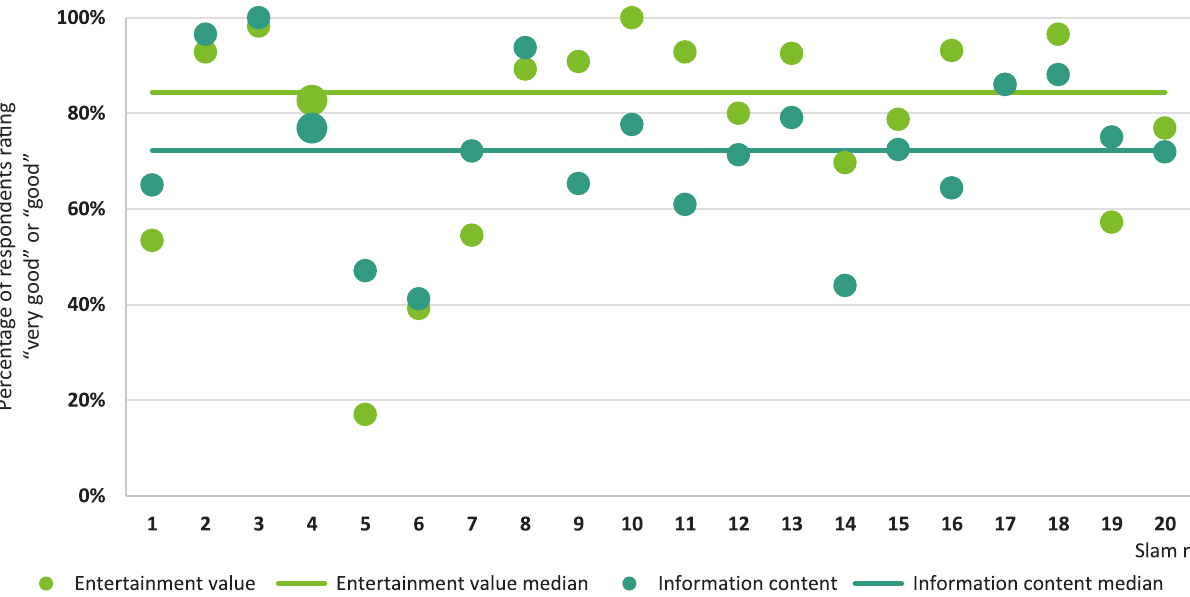
Figure 2. Audience assessment of the entertainment value and the information content of the 20 presentations, both mea- sured as the percentage of survey participants ranking the respective category as either “very good” or “good.” Notes: The data points represent the values for each presentation; the medians of both values are drawn as continuous color-coded lines (51 ≤ n ≤